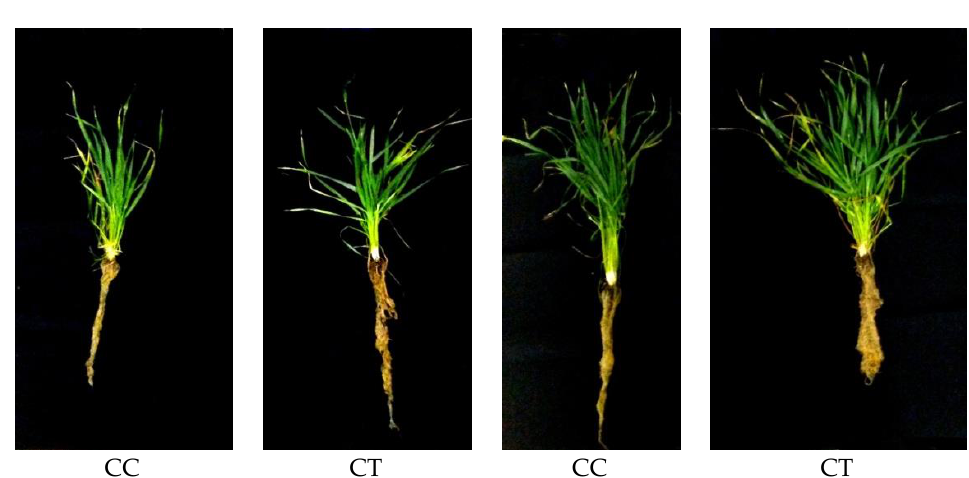
Figure 2. Shoot and root development in wheat plants under well-watered and water/nutrient stress conditions at 25 dps, CC: Coated control; CT: Coated with thyme oil.